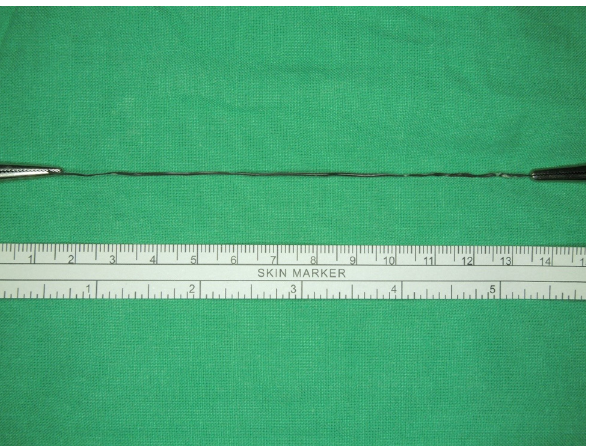
Figure 3: The video image of fURS and the laser probe ( arrow ) for cutting the underlying renal parenchyma for exposure of the embedded material.